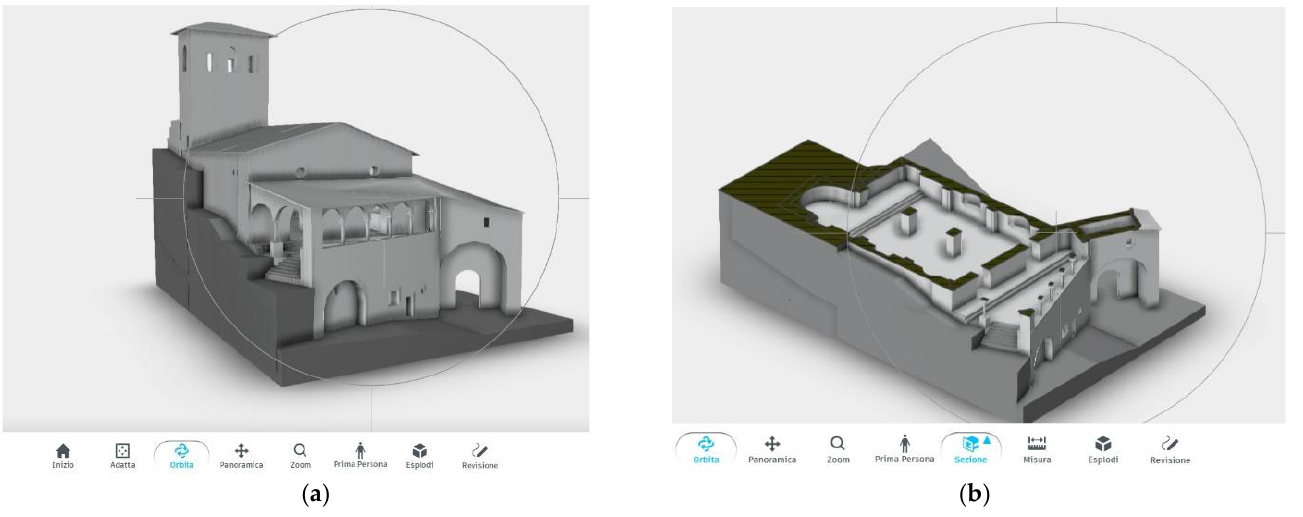
Figure 14. Autodesk viewer® visualization: ( a ) complete; and ( b ) section option.